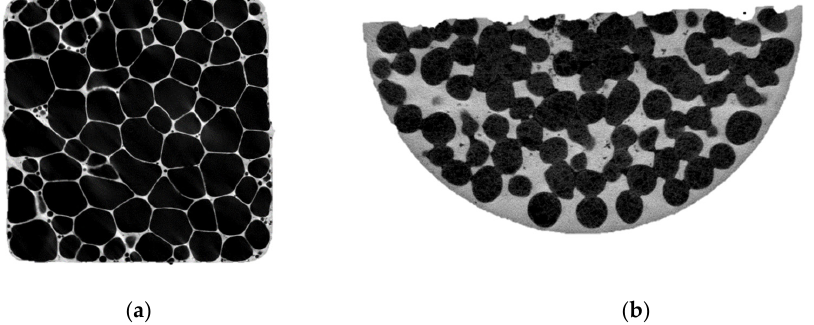
Figure 2. Closed-cell foam (cross section: 20 mm × 20 mm) ( a ) and syntactic foam (diameter: 30 mm) ( b ).